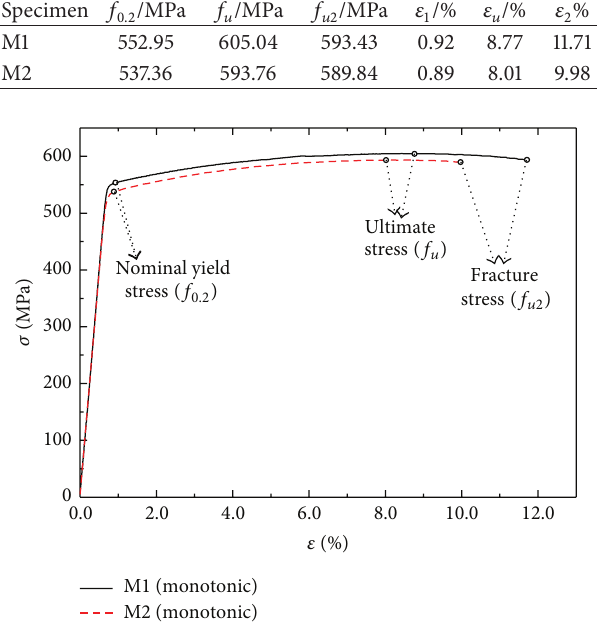
Figure 4: Stress-strain curves of monotonic loading.